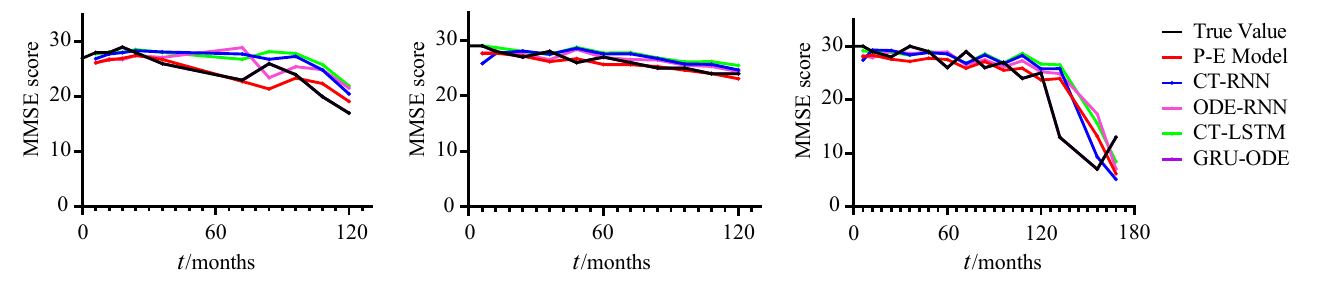
Figure 7. The prediction results of